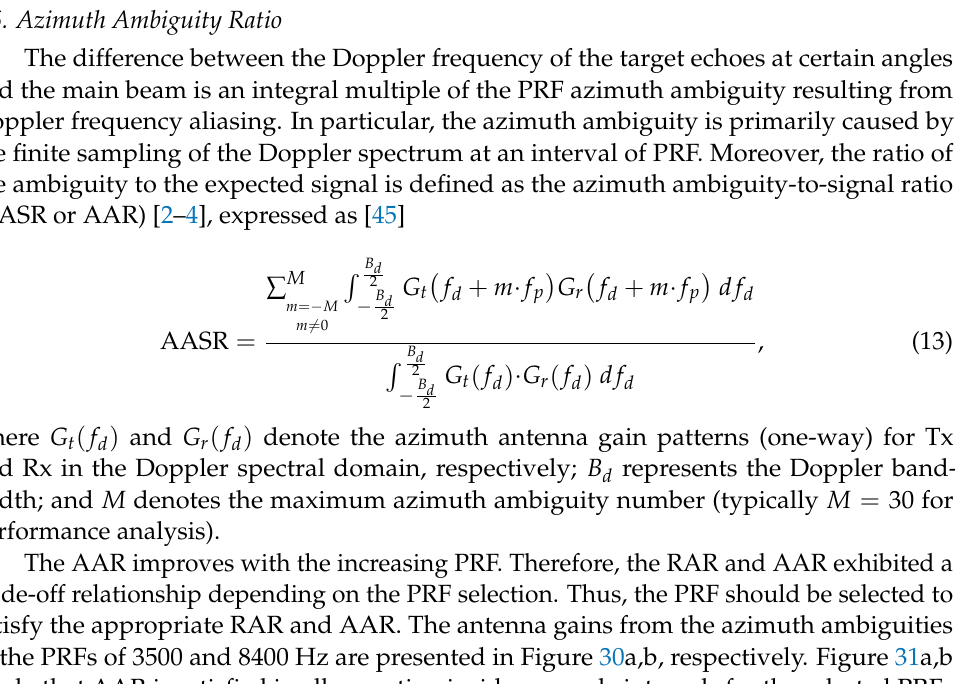
Figure 29. Range ambiguity ratio vs. incidence angle in ( a ) high-resolution and ( b ) wide-swath modes. RAR was lower than the required level of − 17 dB at the incidence angle of 25°. Each color shows the corresponding swath.